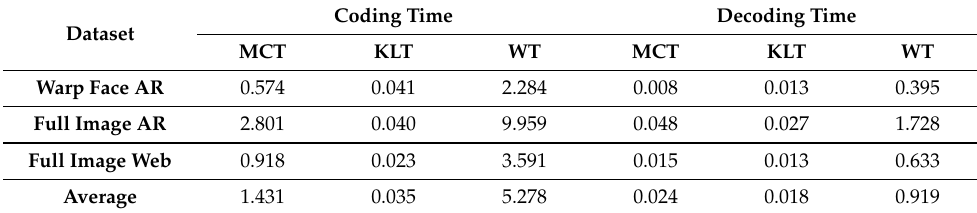
Table 1. Execution time for the proposed MCT and the existed methods KLT and WT.